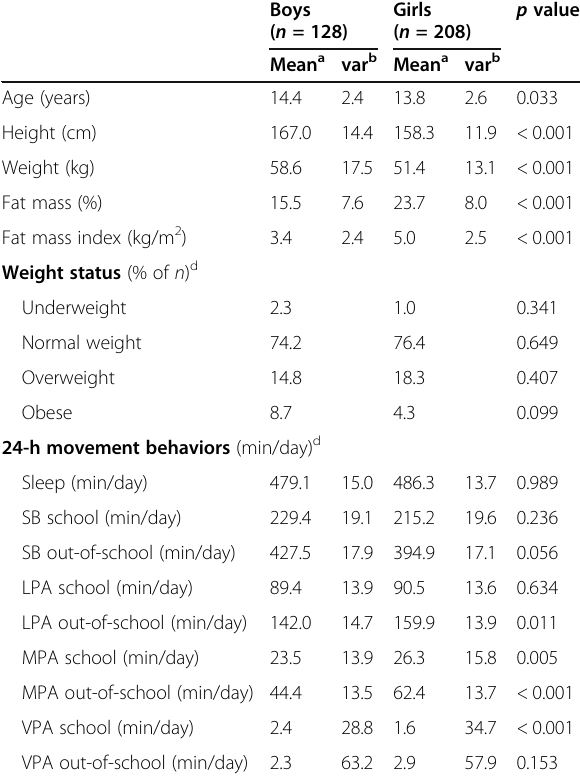
Table 1 Descriptive characteristics of the study